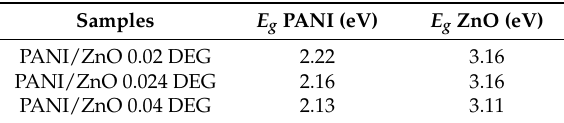
Table 5. Energy bandgap ( E g ) determined from ultraviolet (UV)-Vis reflectance